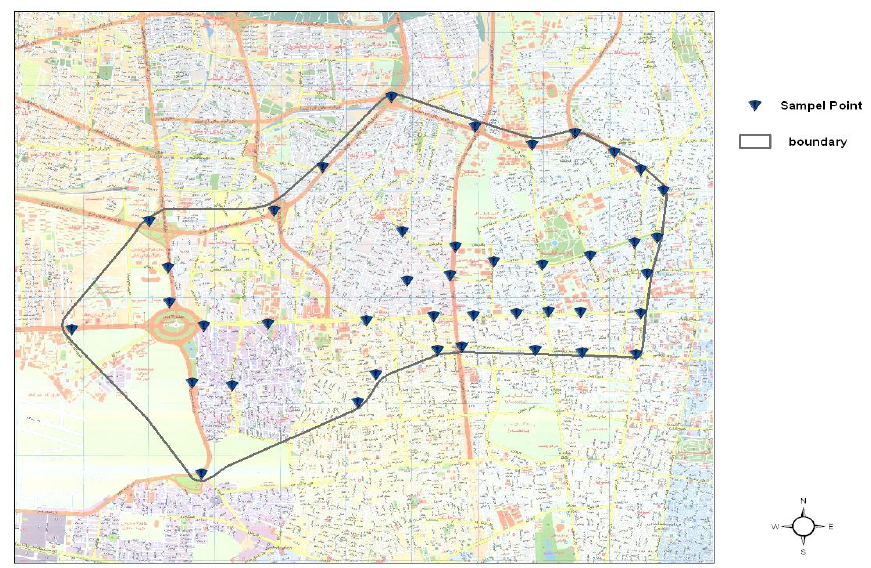
Figure 1. The borderline of the sampling